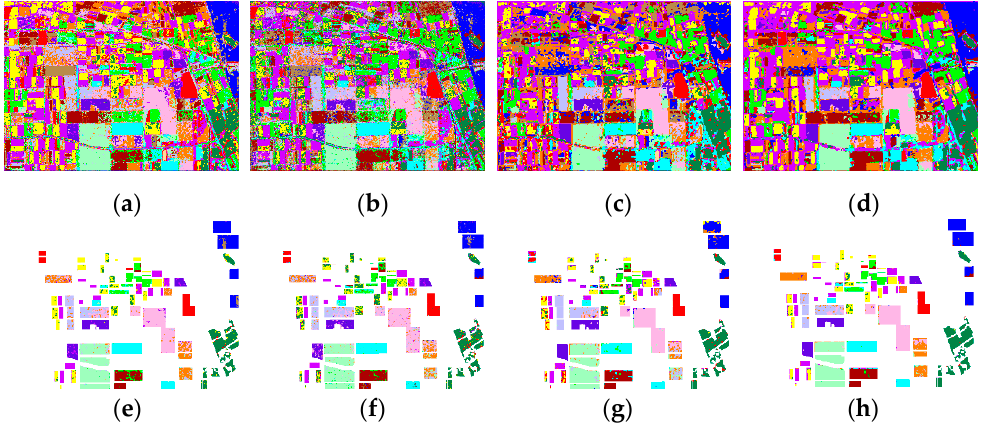
Figure 5. Classification results for the Flevoland dataset. ( a – d ) Classification results of the different approaches: ( a ) Wishart, ( b ) SVM, ( c ) CV-CNN, ( d ) proposed method. ( e – h ) Results overlaid with the ground-truth maps of ( a – d ), respectively.